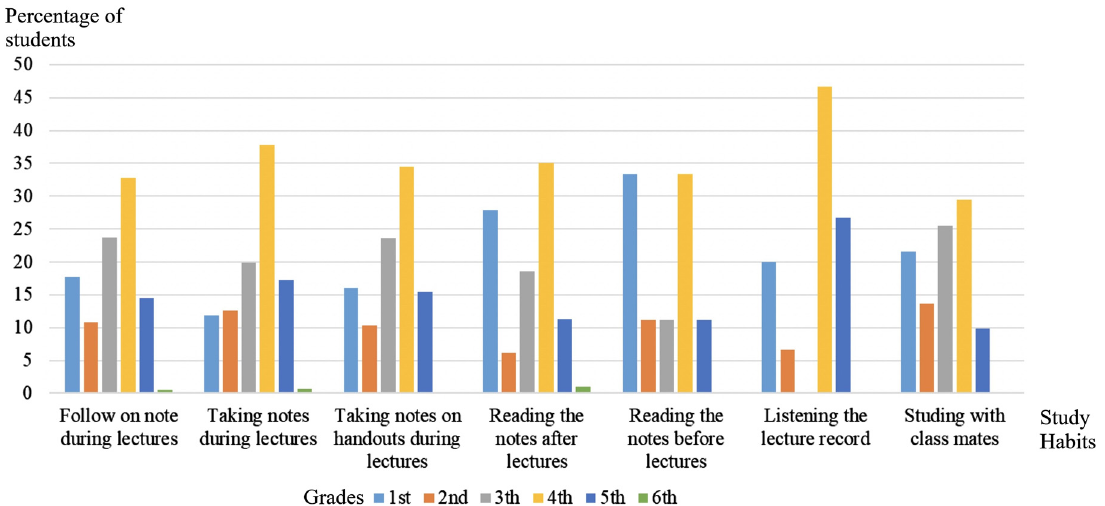
Figure 3: Distribution of students ’ study